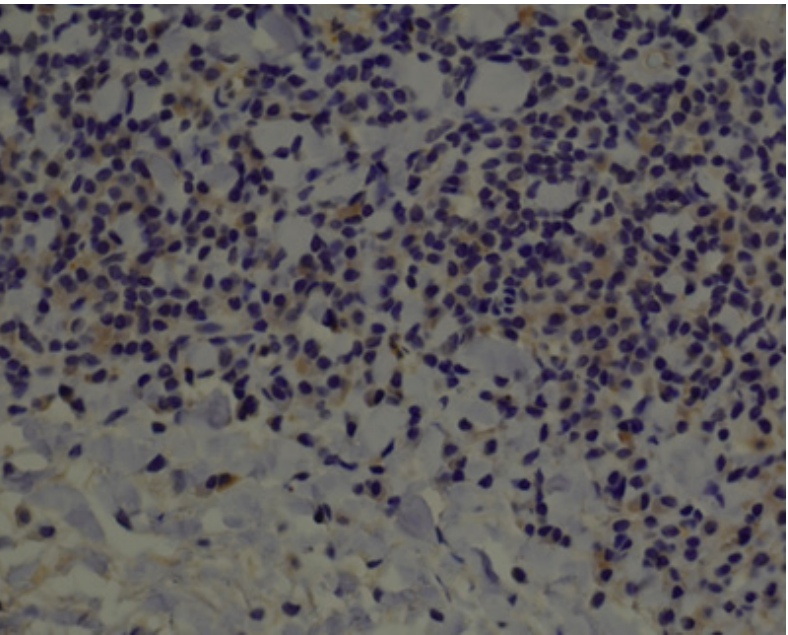
Figure 5. IL-8—weak brown staining in stroma of OED (40x). J. Clin. Med. 2020 , 9 , x FOR PEER REVIEW